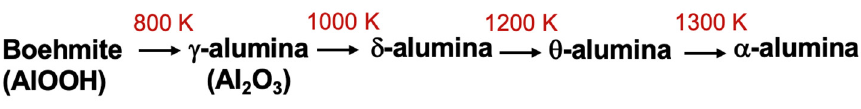
Figure 1. Thermal diagram of transition aluminas derived from calcination of boehmite.